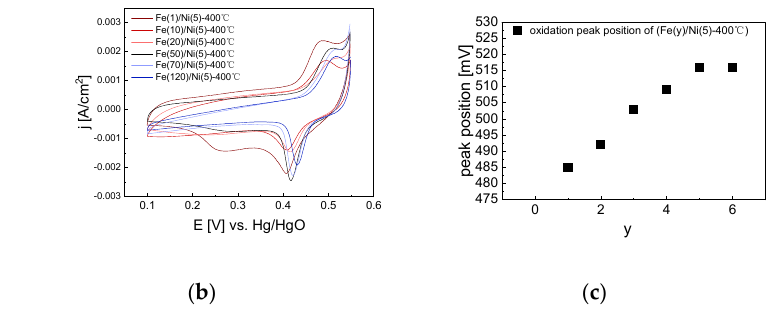
Figure 10. Electrochemical analysis of NiFe-oxide electrodes varying with Fe impregnation concen-